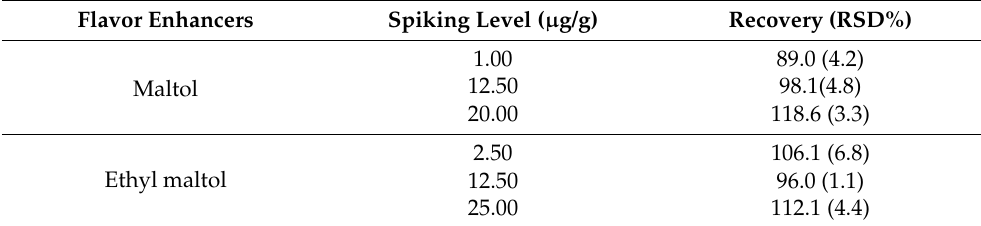
Table 3. Recovery of maltol and ethyl maltol in samples a . Flavor Enhancers Spiking Level ( µ g/g) Maltol